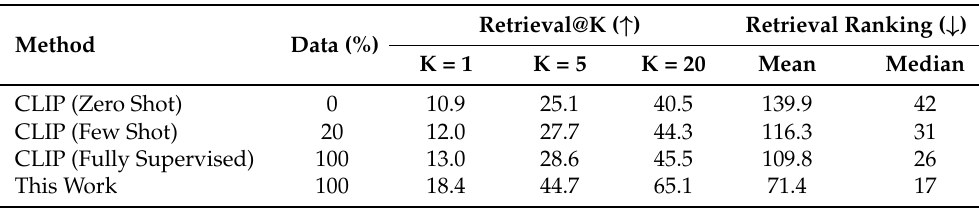
Table 1. Retrieval Results and Comparison of MultiM-Poem Dataset Hold-out Set. ( ↑ : higher is better, ↓ : Lower is better).